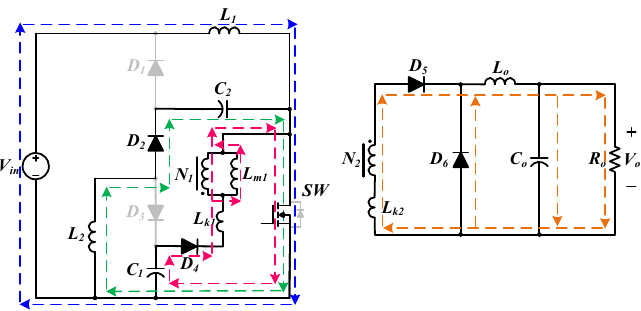
Figure 6. Equivalent circuit of the CHSDC in Mode 1.